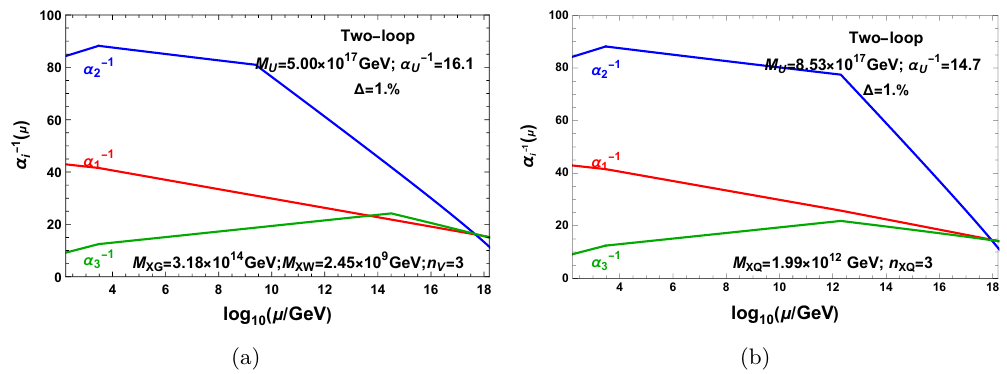
Figure 6 . Two-loop evolution of gauge couplings for the Model 13 with vector-like particles. In the model, k = 11 × 5 and k = 5 . The string-scale gauge coupling relations can be achieved by Y 2 8 3 14 adding 3( XW + XG ) (a) and 3( XQ + XQ ) (b).